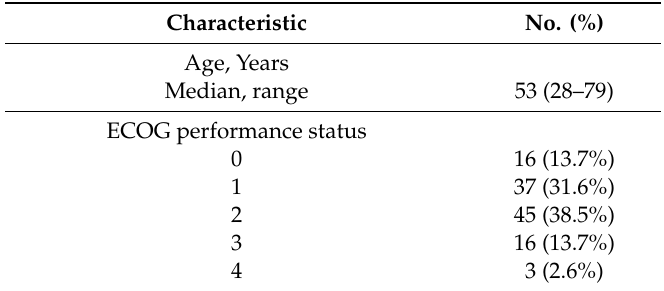
Table 1. Clinico-pathologic characteristics of the patients ( n =